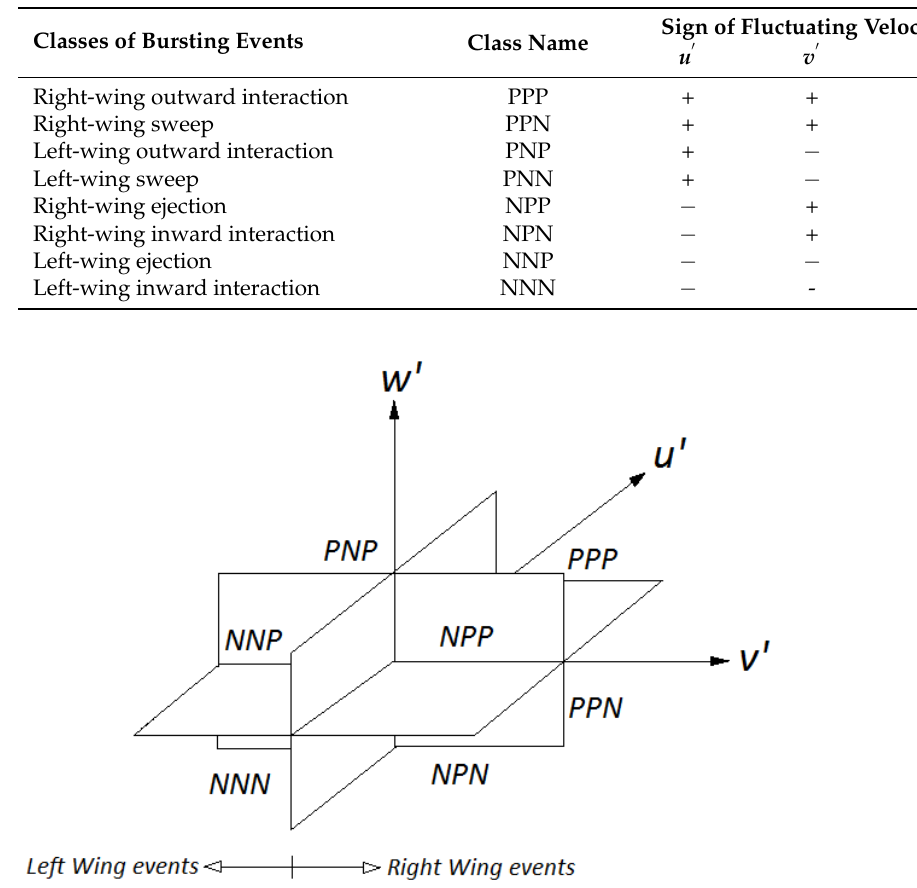
Figure 1. Bursting events in the octant analysis and right-wing and left-wing classification of the events (PNN event which is located in the left wing is not seen in this angle of view).